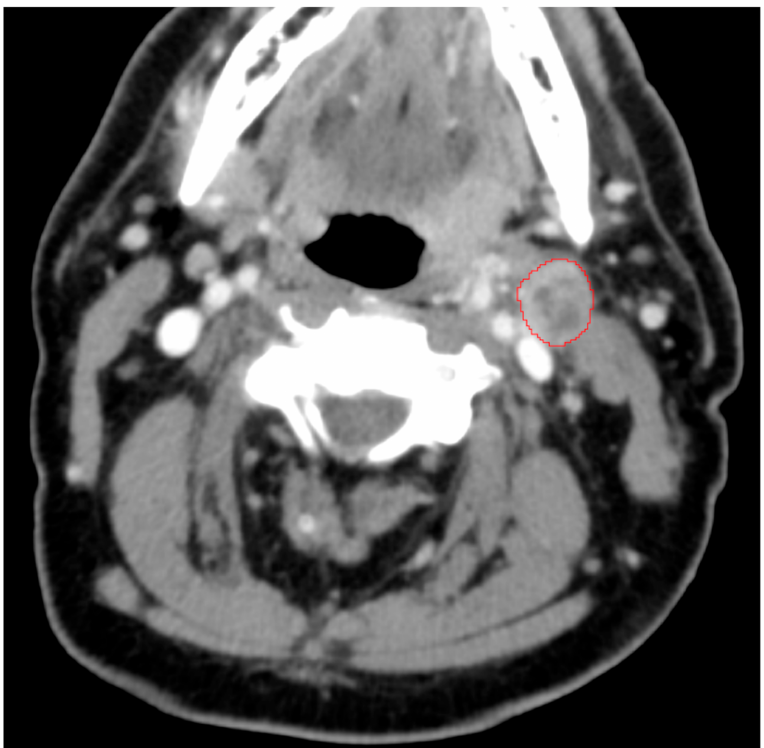
Figure 1. An enlarged lymph node and region of interest outlined on a pretreatment axial CT